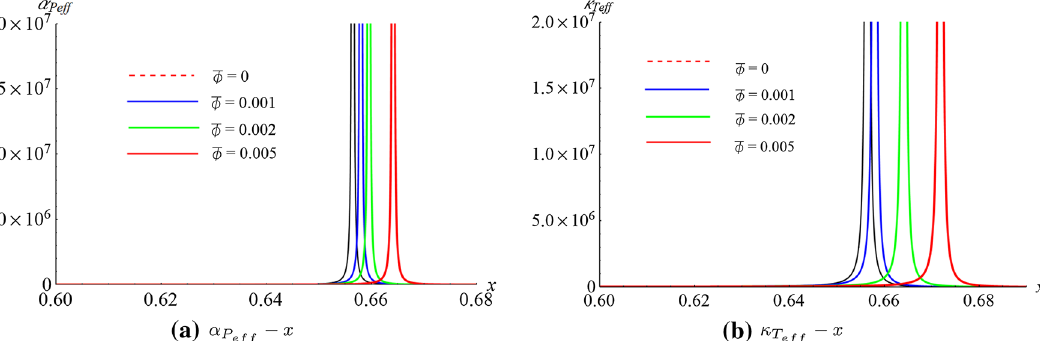
Fig. 4 The isobaric expansion coefficient and the isothermal compression coefficient as the functions of the radio x ( x = r + point with the different charge corrections and the parameters k = 1 , q = 1